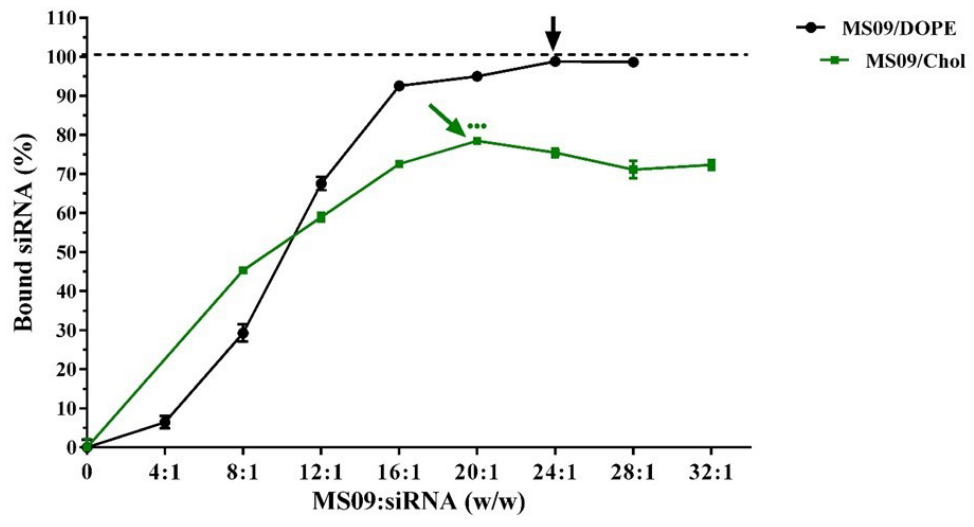
Figure 3. siRNA-binding at varying MS09:siRNA ( w / electrophoresis. Data is presented as the mean ± SD ( n = 3). The point at which each formulation best bound siRNA is indicated by an arrow. ●●● P < 0.001 vs. DOPE-containing counterpart at the respective MS09:siRNA ( w /